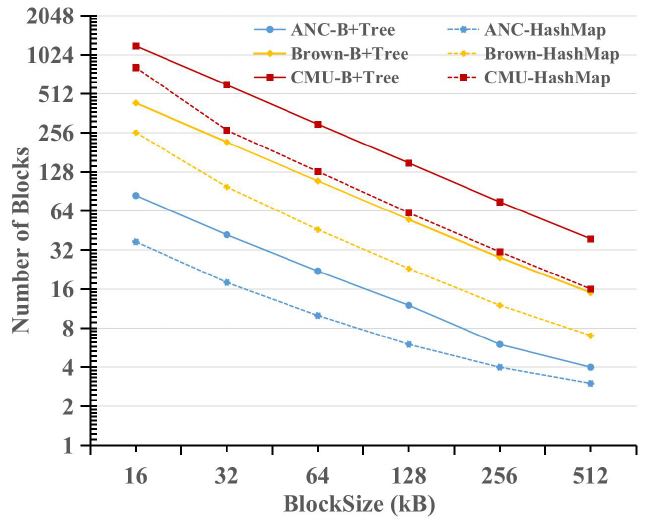
Figure 6. The number of blocks occupied in